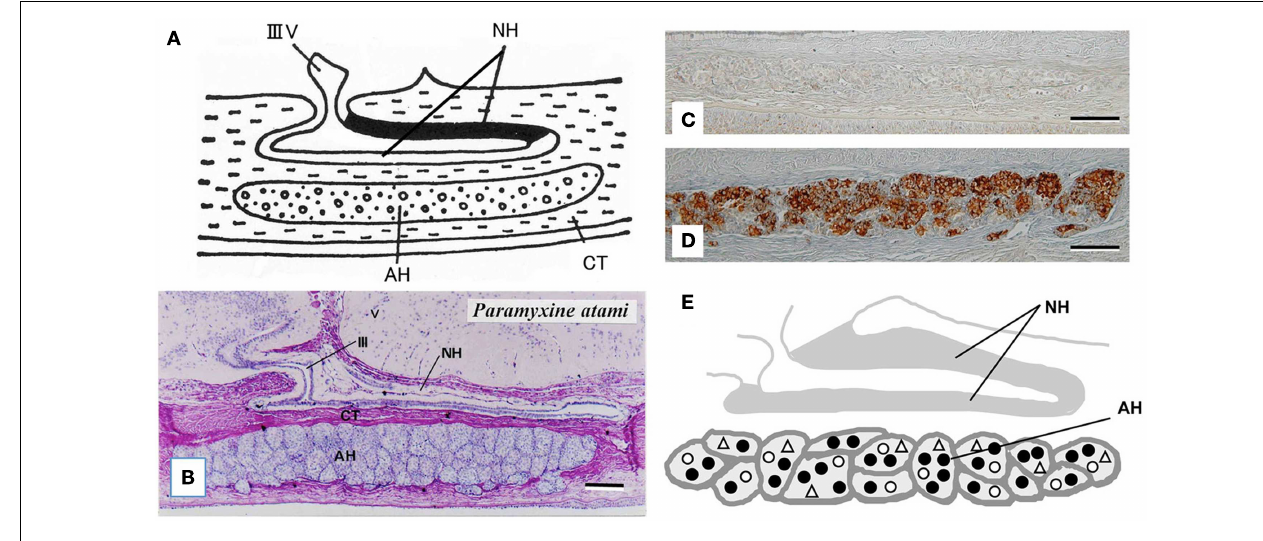
anti-hagfish GTH β . Note that GTH-positive cells are almost absent in (C) , whereas they are abundant in (D) . (E) , Diagrammatically sagittal section of the hagfish pituitary gland showing the topographic distribution of adenohypophysial cells. Closed circle, GTH cell; open circle, ACTH cell; open triangle, undifferentiated cell and possible GH cell. AH, adenohypophysis; CT, connective tissue; IIIV, third ventricle. Scale bars: 100 µ